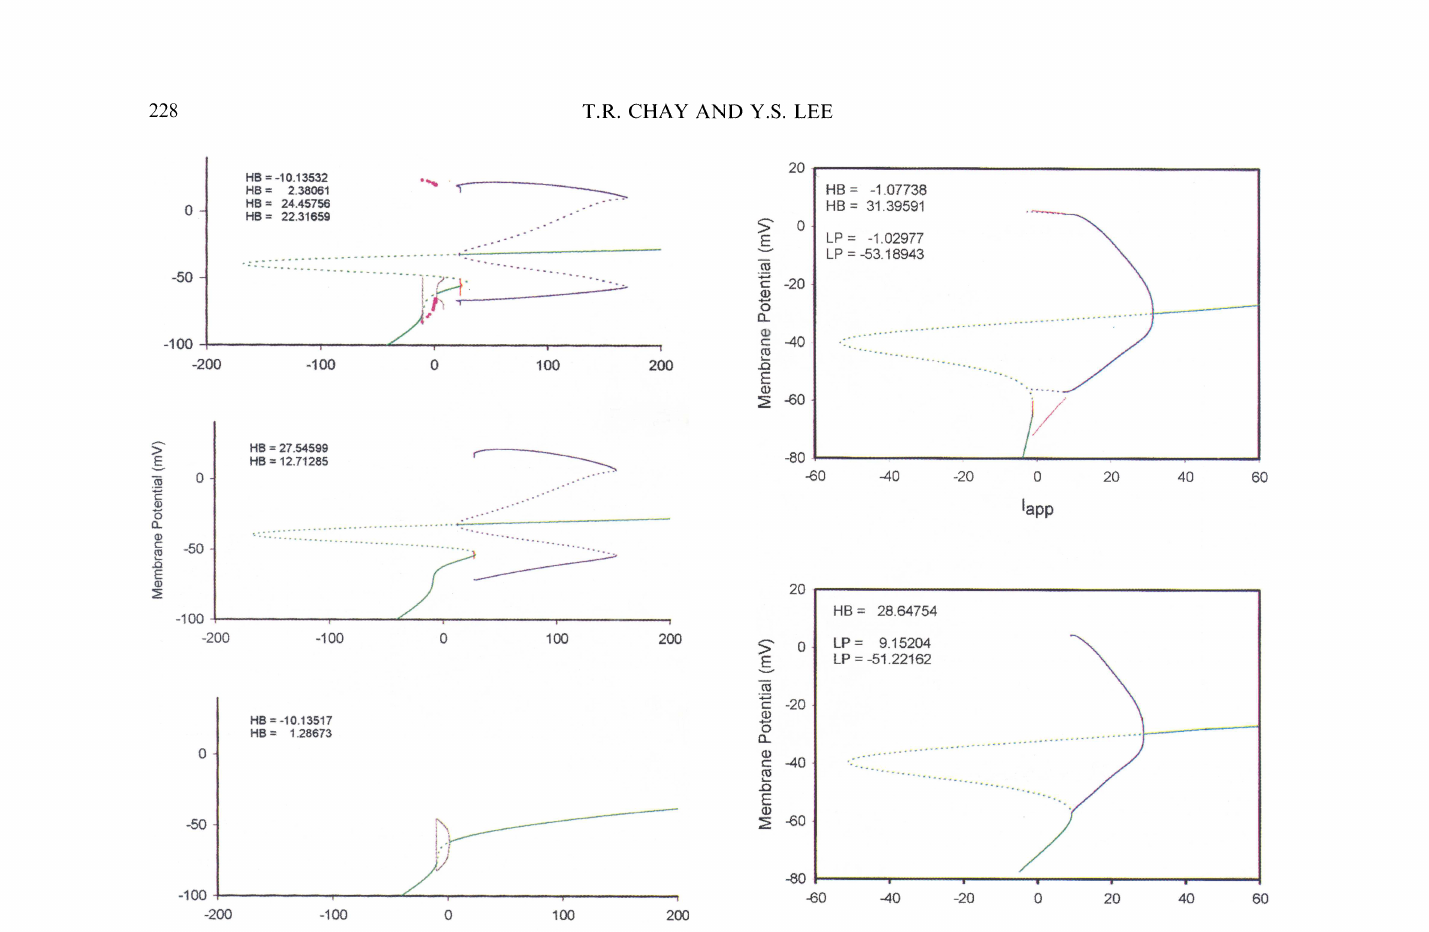
FIGURE 11 AUTO plot showing the membrane potential vs. Imp for the pyramidal neuron. In the bottom frame, the gating variable (p) of I:(c0 is fixed at 300/(KKc + 300). In the top and bottom frames, the green lines represent steady state branches and blues lines represent spiking envelopes. In the top frame the pink solid line was obtained using the dynamic solution, since AUTO was unable to continue in the bursting regime. (See Color Plate